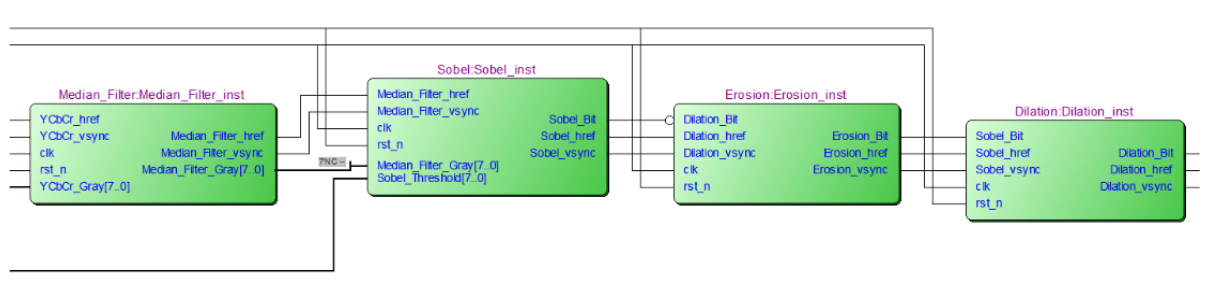
Figure 6. FPGA-based image processing algorithm RTL diagram.